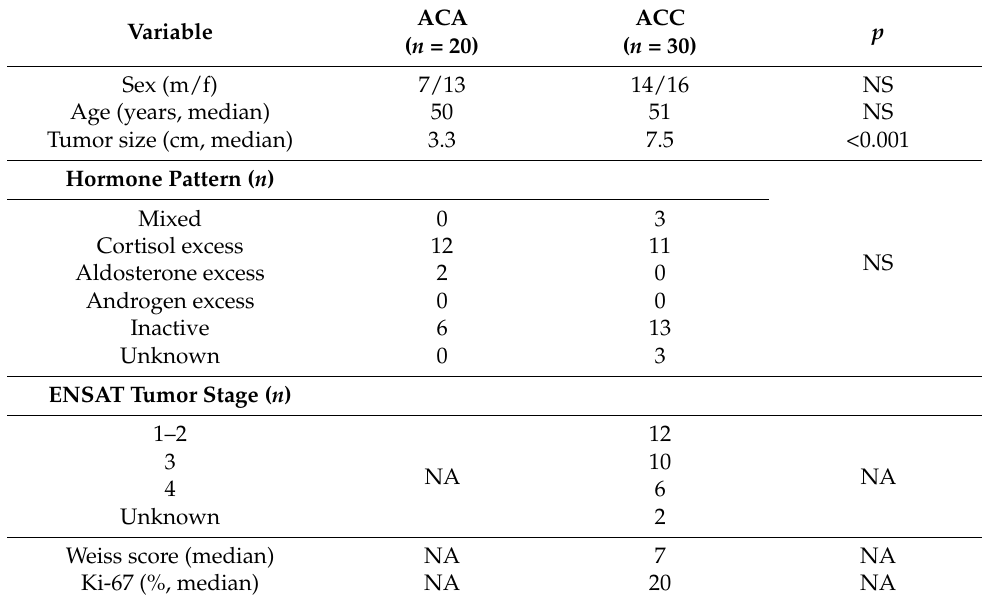
Table 1. Demographic data and clinical parameters for patients with adrenocortical tumors ( n = 50).